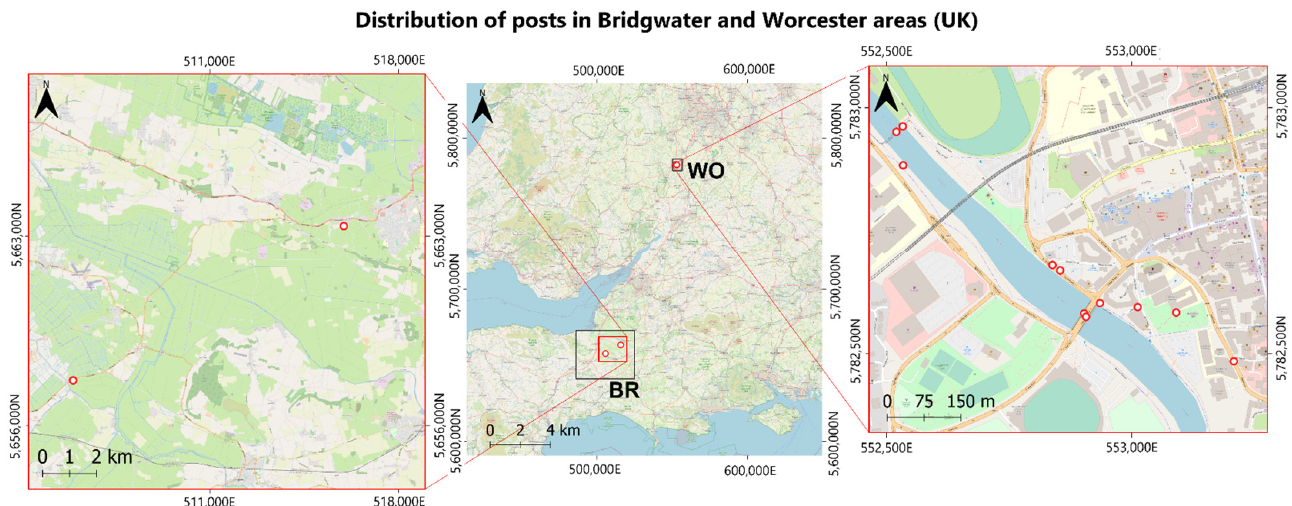
Figure 3. Distribution of posts used to build floodwater training samples for the Bridgwater and Worcester areas (UK). CRS: WGS84/UTM zone 30 N. Basemap data: OpenStreetMap contributors.